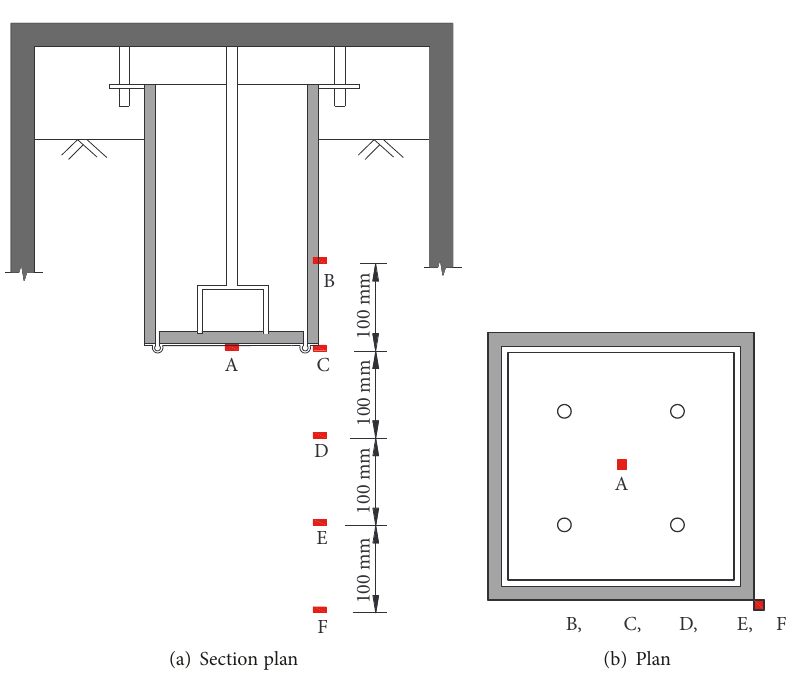
Figure 4: Layout of the pore pressure